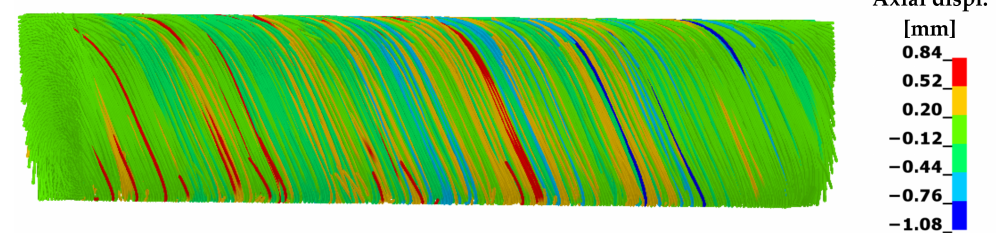
Figure 10. Compaction